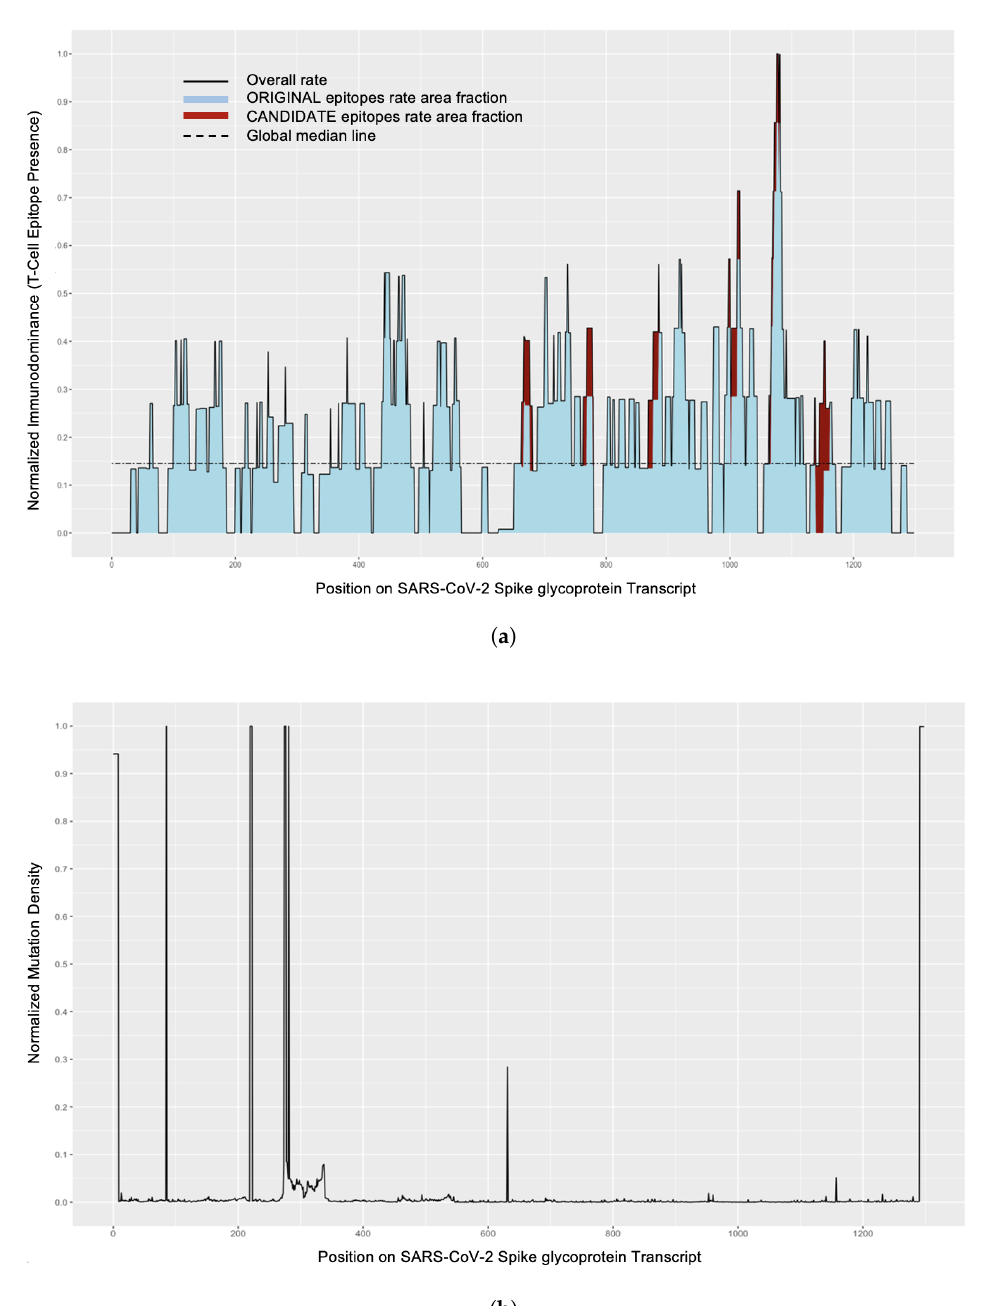
Figure 2. Immunodominance plot and mutagenesis plots. ( a ) Stacked area plot depicting normalized T cell epitope presence across the length of the Spike glycoprotein transcript (total length: 1299 amino acids). The graph is colored by epitope origin, with original epitope rates in blue and newly predicted epitope rates in red. ( b ) Mutation density plot for the Spike glycoprotein; logs normalized mismatch frequency rates across the protein as compared to the consensus